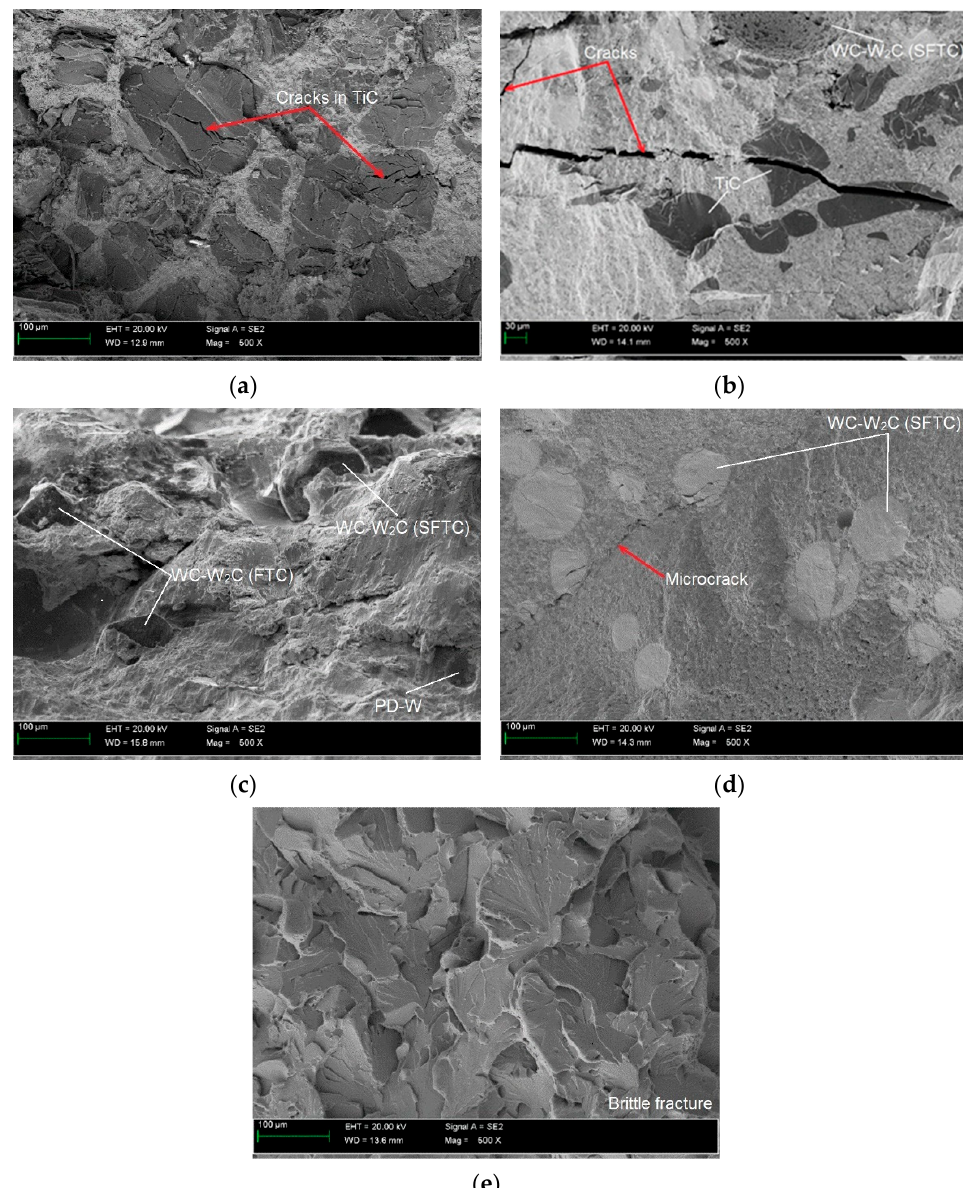
Figure 11. SEM images of the brittle fracture surface for samples: ( a ) C1; ( b ) C2; ( c ) C3; ( d ) C4; ( e ) base material.